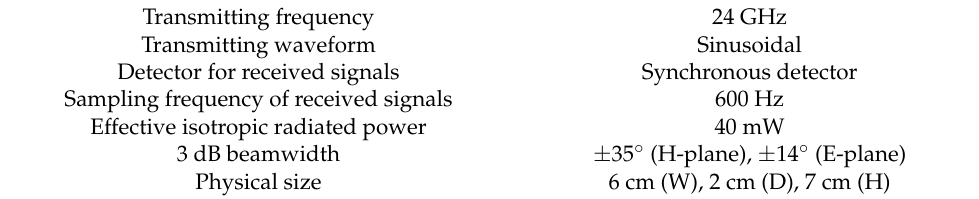
Figure 1. Micro-Doppler radar (MDR) sensing system for gait measurement. ( a ) Measurement system model; ( b ) Experimental site; ( c ) Block diagram of the MDR. Table 1. MDR